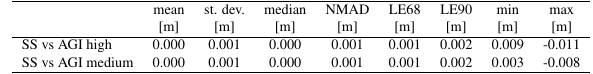
Table 2: 3D distance models comparison (distance statistics). mean st. dev. median NMAD LE68 LE90